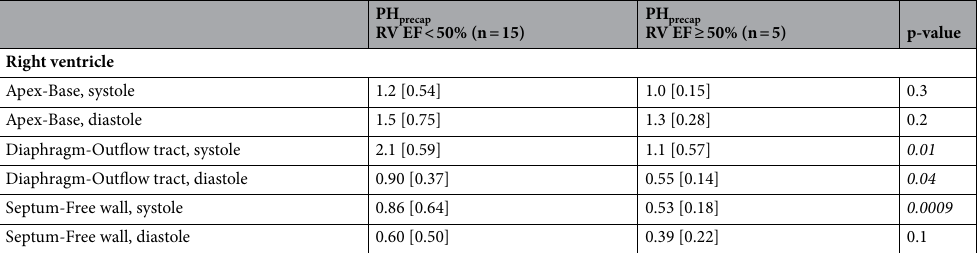
Table 4. Right ventricular hemodynamic forces indexed to stroke volume (N/l) for patients with PH precap grouped by ejection fraction. Significant values are in [italics]. Root mean square right ventricular (RV) hemodynamic forces indexed to RV stroke volume (SV) in patients with precapillary pulmonary hypertension (PH preap ) and controls. Data is expressed as median [IQR].